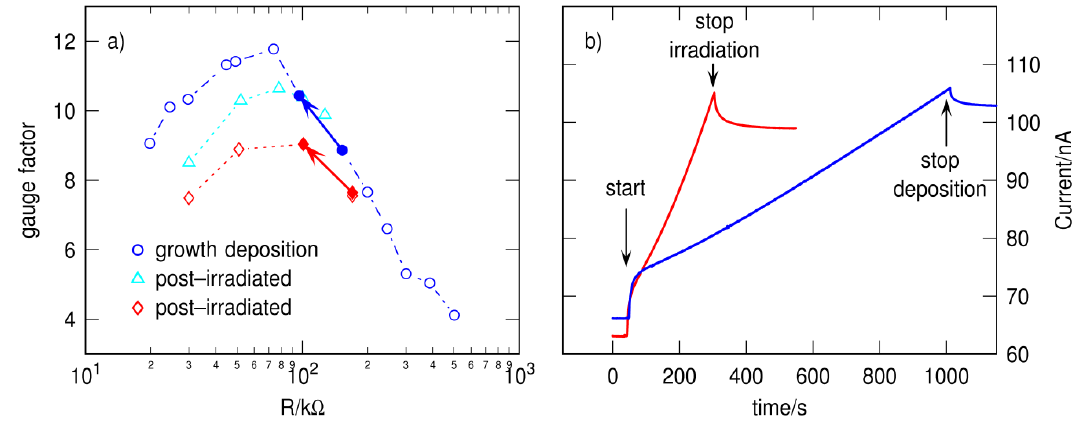
Figure 4. (a) Measured gauge factors for Pt deposits during growth deposition (circles) and for post-irradiated deposits (triangles, diamonds). The two arrows indicate the displayed in situ conductivity measurements as a function of time during deposition (blue arrow) and post-irradiation (red arrow) shown in (b); (b) Conductivity measurements during deposition (blue) and post-irradiation (red) for a bias voltage of 10